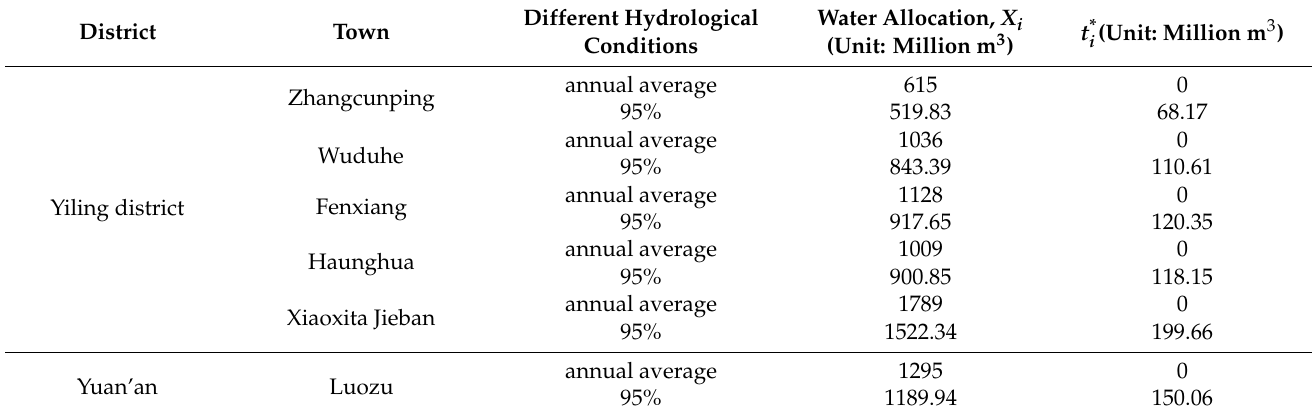
Table 2. Water resource allocation with symmetric